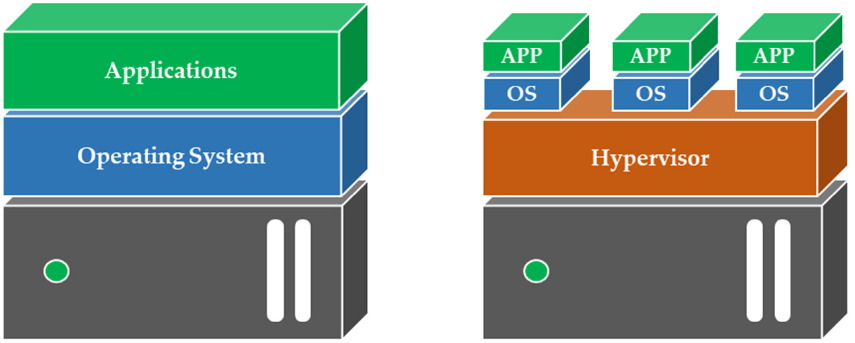
Figure 1. Traditional and virtual architecture server comparison.